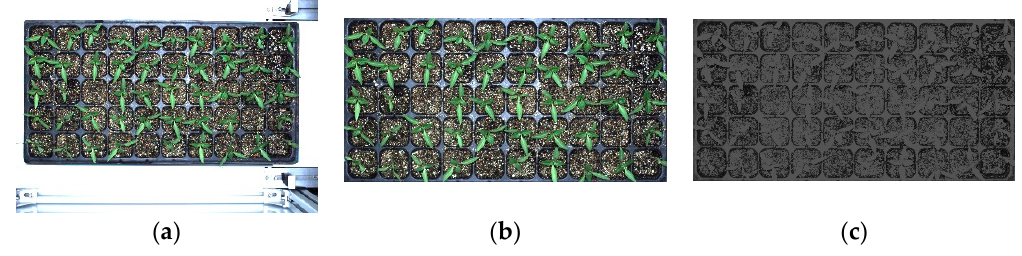
Figure 4. ( a ) Original image. ( b ) ROI RGB image. ( c ) ROI grayscale image.